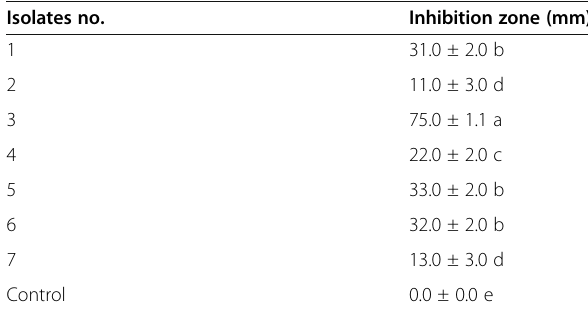
Table 1 Percentage of Penicillium digitatum growth inhibition caused by different yeast strain in vitro Isolates